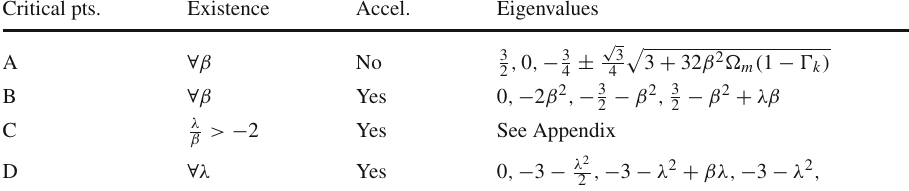
Critical pts. Existence